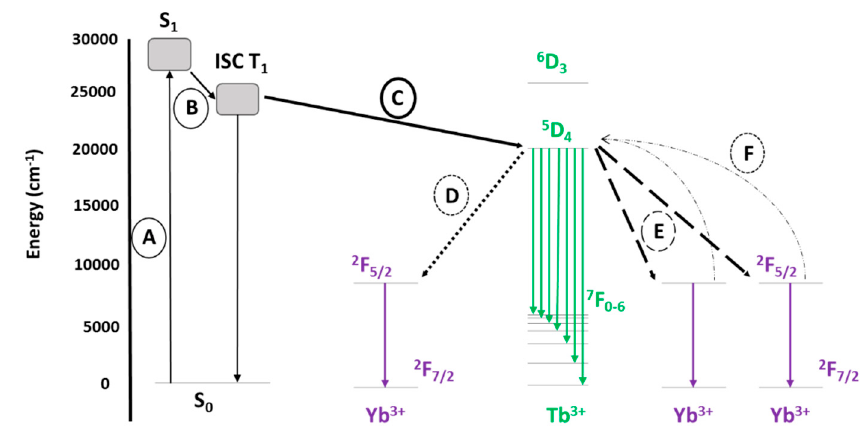
Figure 7. Proposed energy level diagram involving ligand Tb(III) and Yb(III) in the Tb / YbL 4 sample.